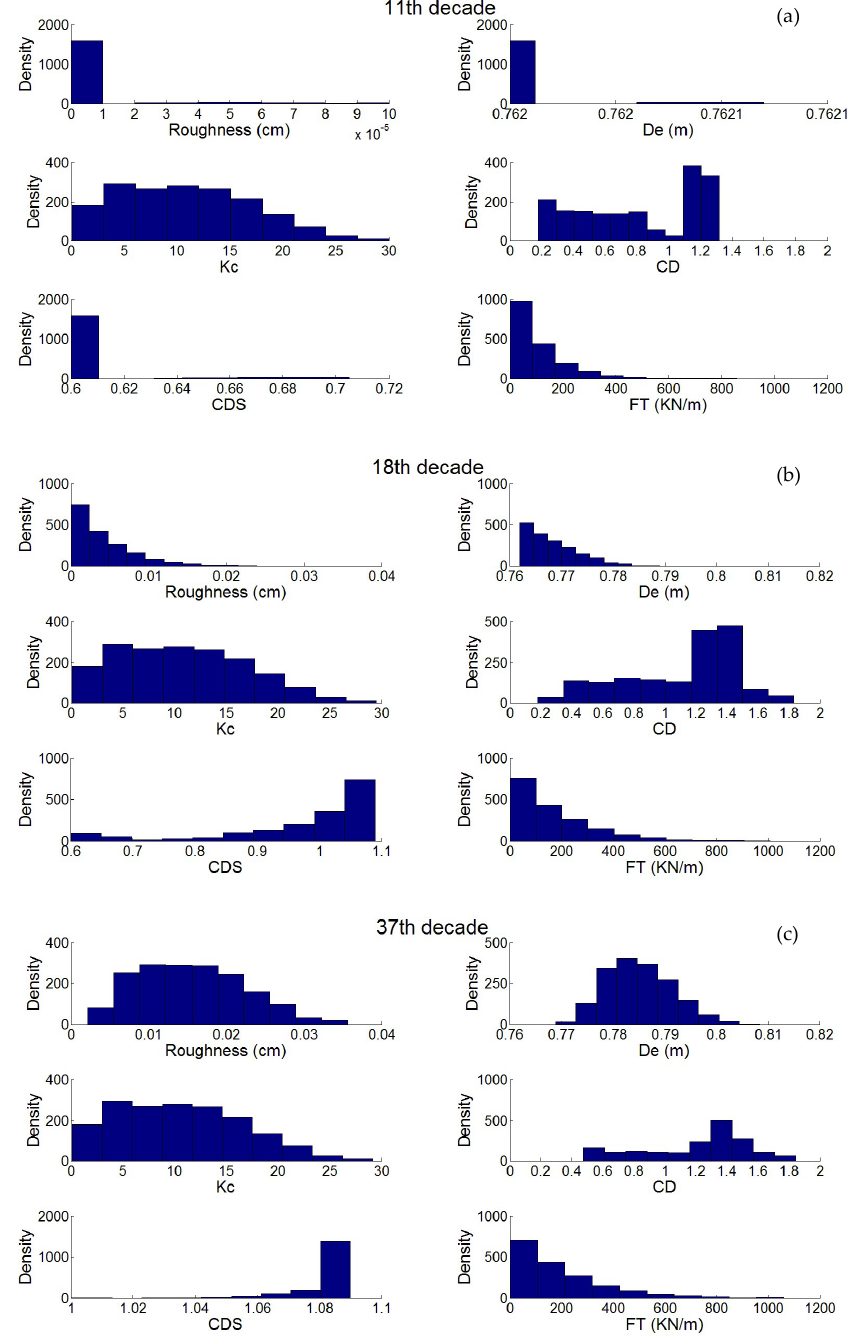
Figure 16. Comparison of the distribution of hydrodynamic parameters for the selected 10 day periods: ( a ) 11 th , ( b ) 18 th , ( c ) 37 th .